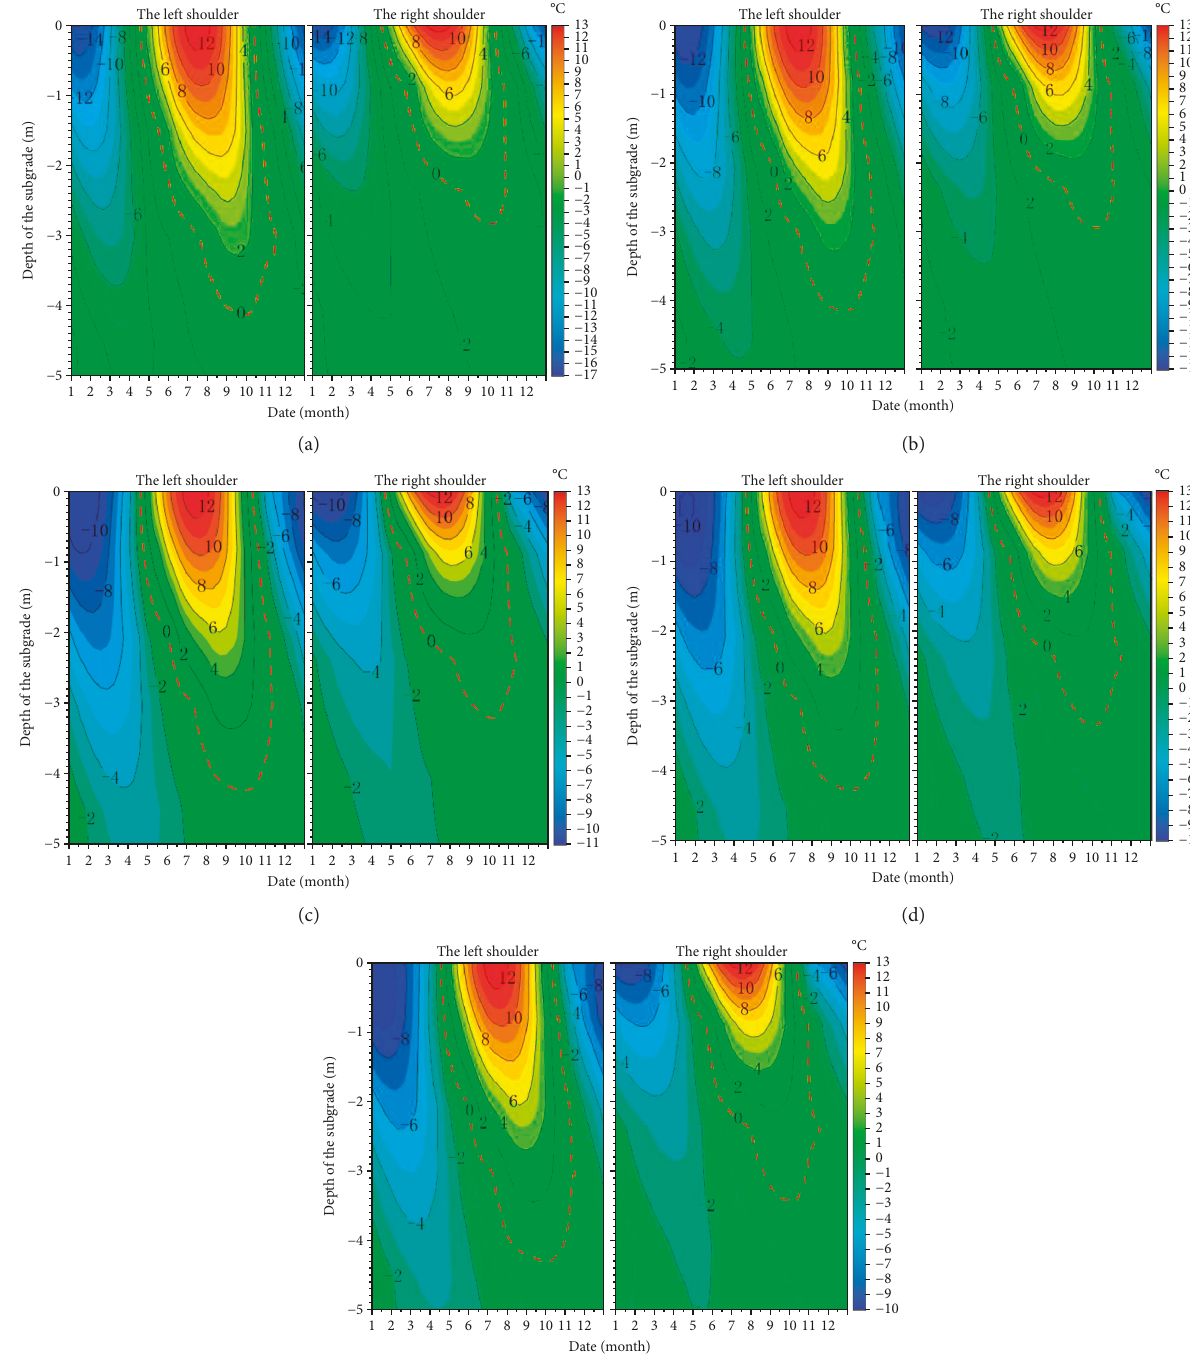
Figure 8: The temperature of different thicknesses of snow cover varies with time under roadbed after 30years of operation, (a) 0cm snow cover, (b) 10cm snow cover, (c) 30cm snow cover, (d) 50cm snow cover, (e) 70cm snow